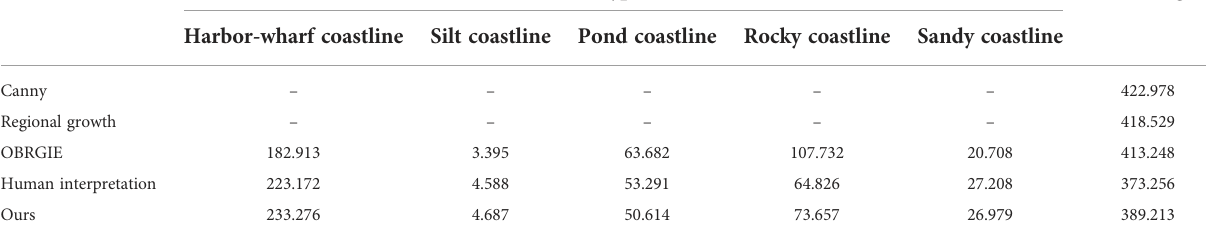
TABLE 5 Length statistics of coastline types by different methods (unit: km).